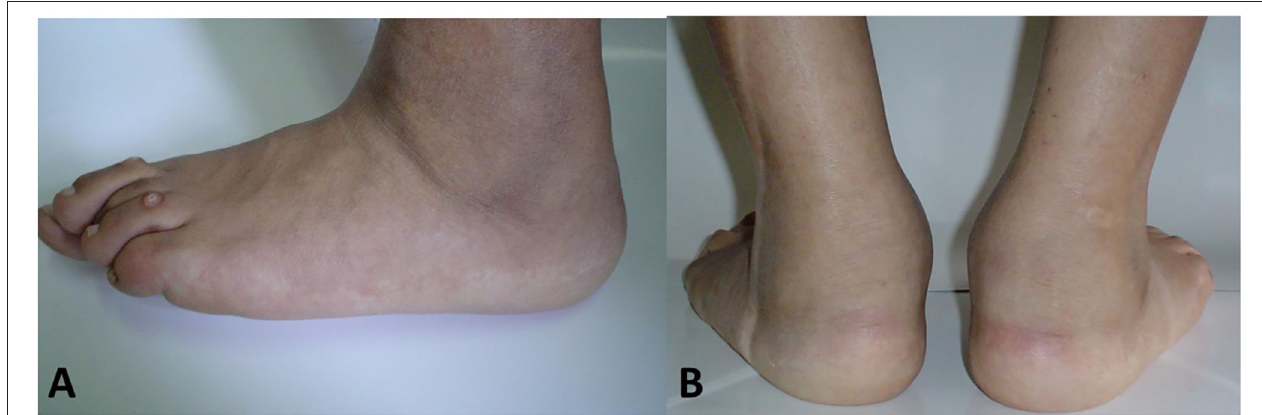
FIGURE 1 | Lateral (A) and coronal (B) T-2 weighted-fat suppressed MR imaging showing edema in various tarsal bones, joint spaces and soft tissues in a 16 year old boy with chronic ankylosing tarsitis [Modified from Burgos-Vargas